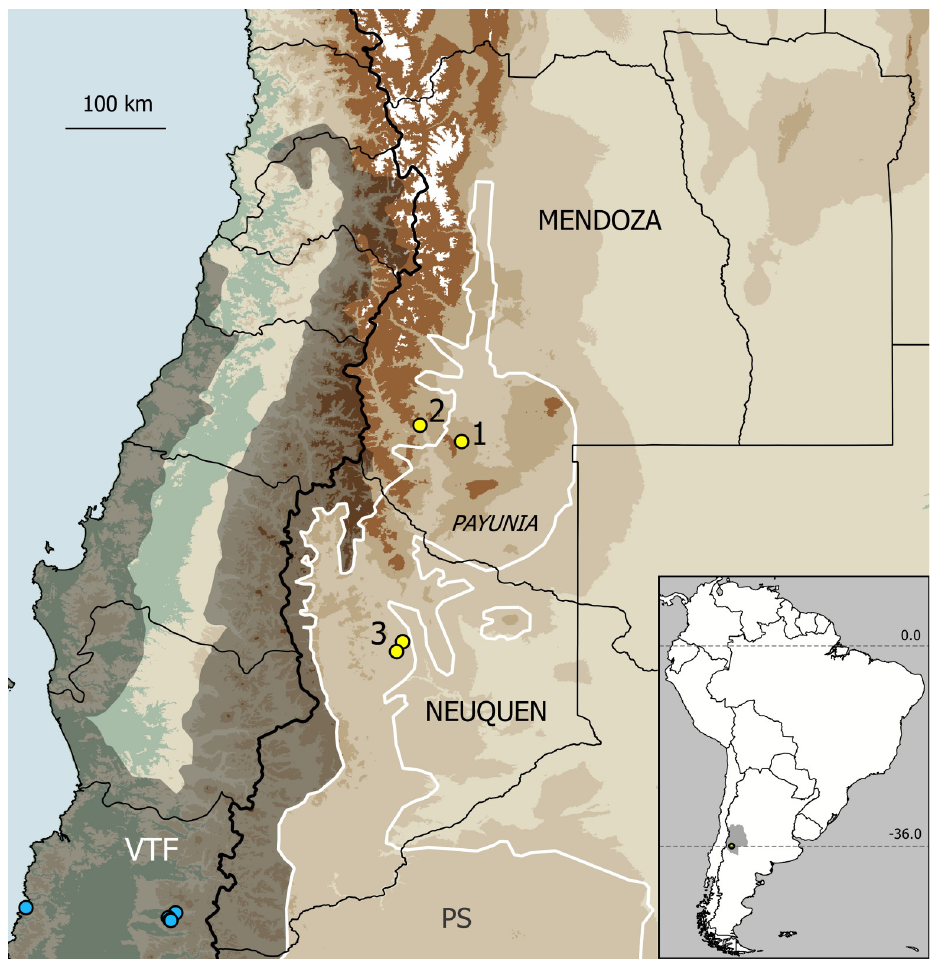
Fig 8. Location of Do ñ a Otilia cave in the Payunia region (Mendoza Province, Argentina). The site is indicated as (1). Other caves in the area with records of Gonyleptidae: (2) Caverna de Las Brujas; (3) Caverna de Chorriaca and Caverna Aguada de la Mula, Neuque´n Province. Light-blue dots: records of Osornogyndes tumifrons Maury, 1993 in Osorno Province, Chile. Ecoregions (following [59]): Patagonian Steppe (PS, white outline) and Valdivian Temperate Forests (VTF, shaded). Inset: position of Mendoza Province (grey) and the type locality (dot) in South America.